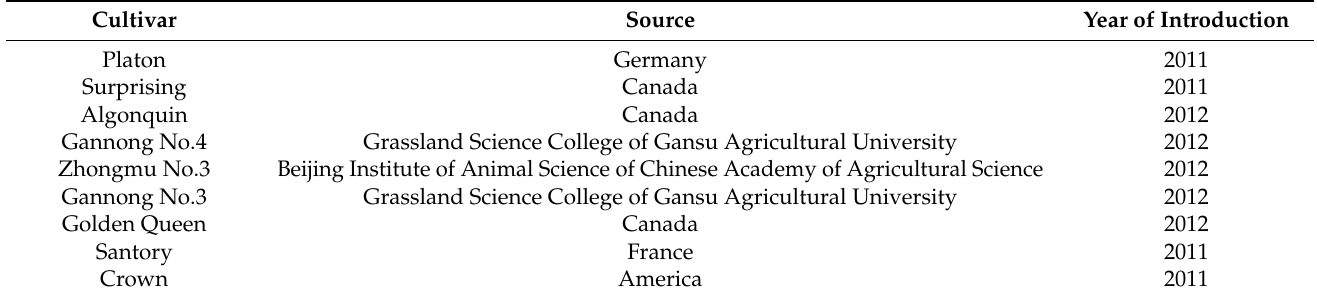
Table 1. Alfalfa were used in a biological control field study involving the pea aphid, Acyrthosiphon pisum , in Ningxia Region, China, in